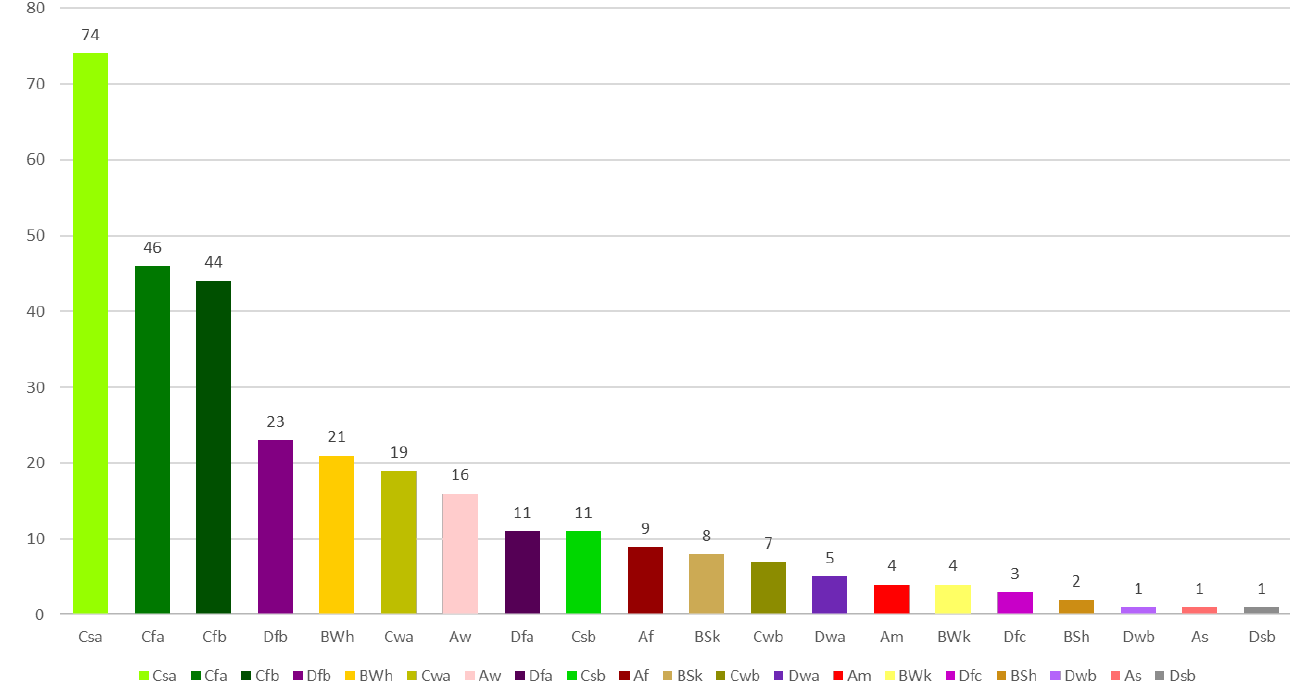
Figure 5. The distribution of Köppen-Geiger climate classification zones according to the studied locations. (See Appendix C for a detailed explanation of the Köppen-Geiger climate classification scheme).